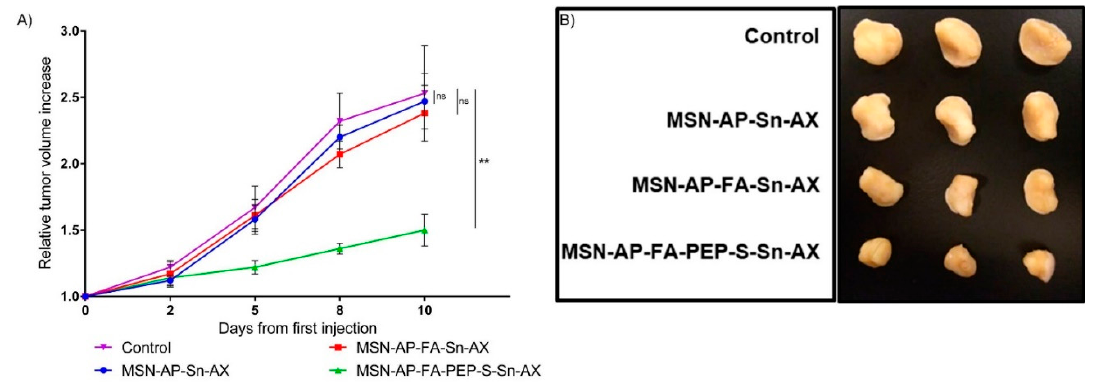
Figure 10. ( A ) Relative tumor volume increase over the course of the treatment with the nanomaterials or saline (control) (n = 3 mice/group). Significance was calculated by unpaired t-test of one-way ANOVA. ns: p > 0.05 or not significant statistical difference between the groups of data; **: p < 0.01 or significant statistical difference between the two groups of data; ( B ) ex vivo tumor images for all mice treated with different MSN nanomaterials or saline (control).